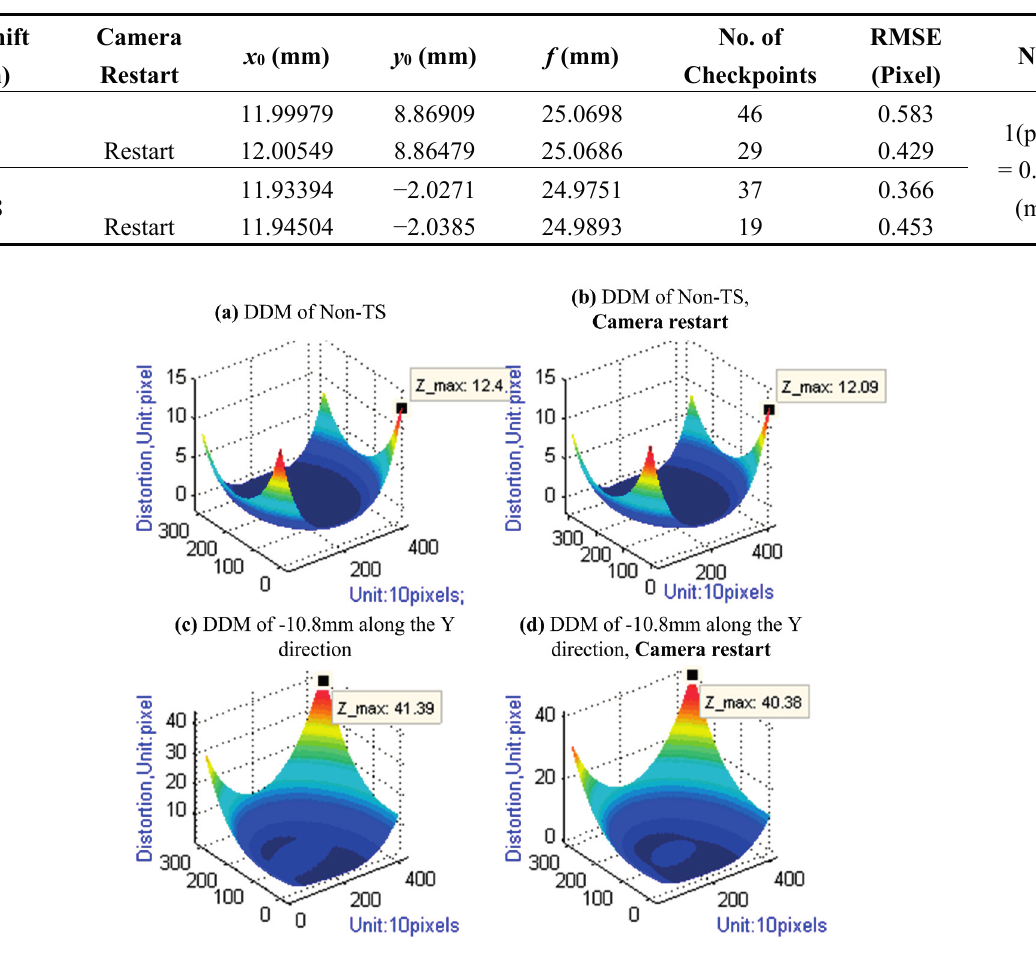
Table 5. IOEs of the camera in the restarting experiment (mm).